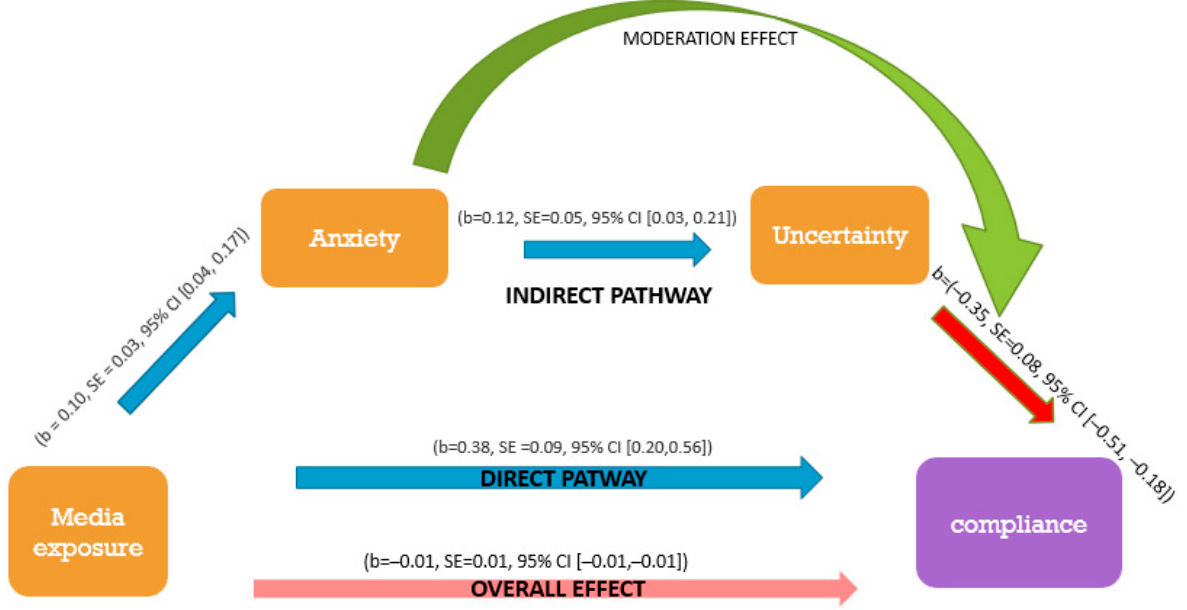
Figure 3. General model of the influence of media exposure change on the intention to comply, including anxiety and uncertainty as mediators. The model fits our data well as described in the body of the text. The moderation effect in the green arrow specified in Figure 2.